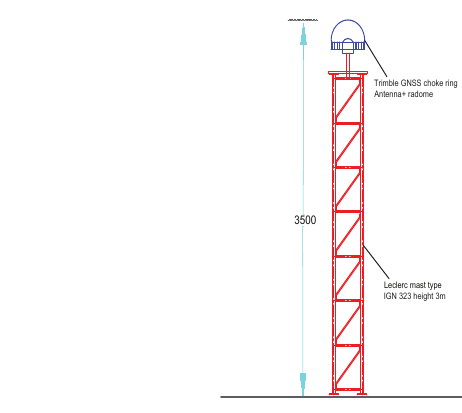
Figure 3. Autocad drawing of GNSS station KBG1 to the ( left ) and KBG2 to the ( right ). All the values are given in millimetres.